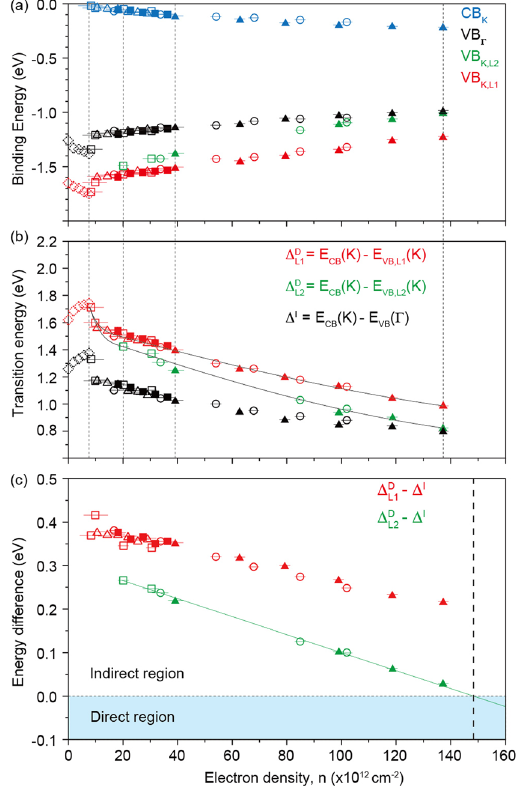
Figure 3. Dosing dependent evolution of the band gap. ( a ) Binding energies of VB Γ , VB K,L1 and VB K,L2 as a function of surface doping concentration. CB K is also shown. Data points drawn with different symbols come from different data sets. Dotted symbols in the low doping region indicate the data from the doping concentration in which CBM could not be observed. Vertical black dotted lines mark the electron densities for = CB − VB the data presented in Fig. 2(b)–(e). ( b ) Doping dependence of the direct gaps ∆ LD K K,L1 and 1 = CB − VB Δ I = CB − VB ∆ LD Γ . In the low doping region where CBM is not seen, the gap K K,L2 , and indirect gap K 2 size is referenced to the Fermi energy. ( c ) The differences between the indirect band gap and two direct band − Δ I indicates transition to a direct gaps at the K-point. A negative value for ∆ LD 2